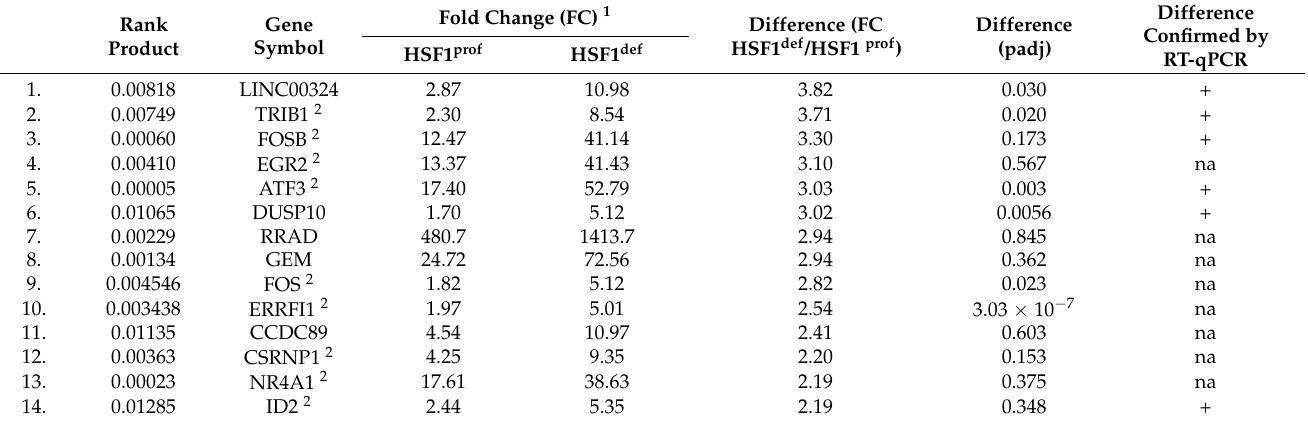
Table 1. List of genes potentially upregulated by HSF1 after heat shock (genes with a lower rank product calculated by the BETA tool are more likely to be HSF1 target genes) in HSF1 prof MCF7 cells that showed stronger upregulation (at least 2-fold as assessed by RNA-seq analyses) in HSF1 def cells. RT-qPCR analysis was performed on another the HSF1+ and HSF1 − MCF7 cell